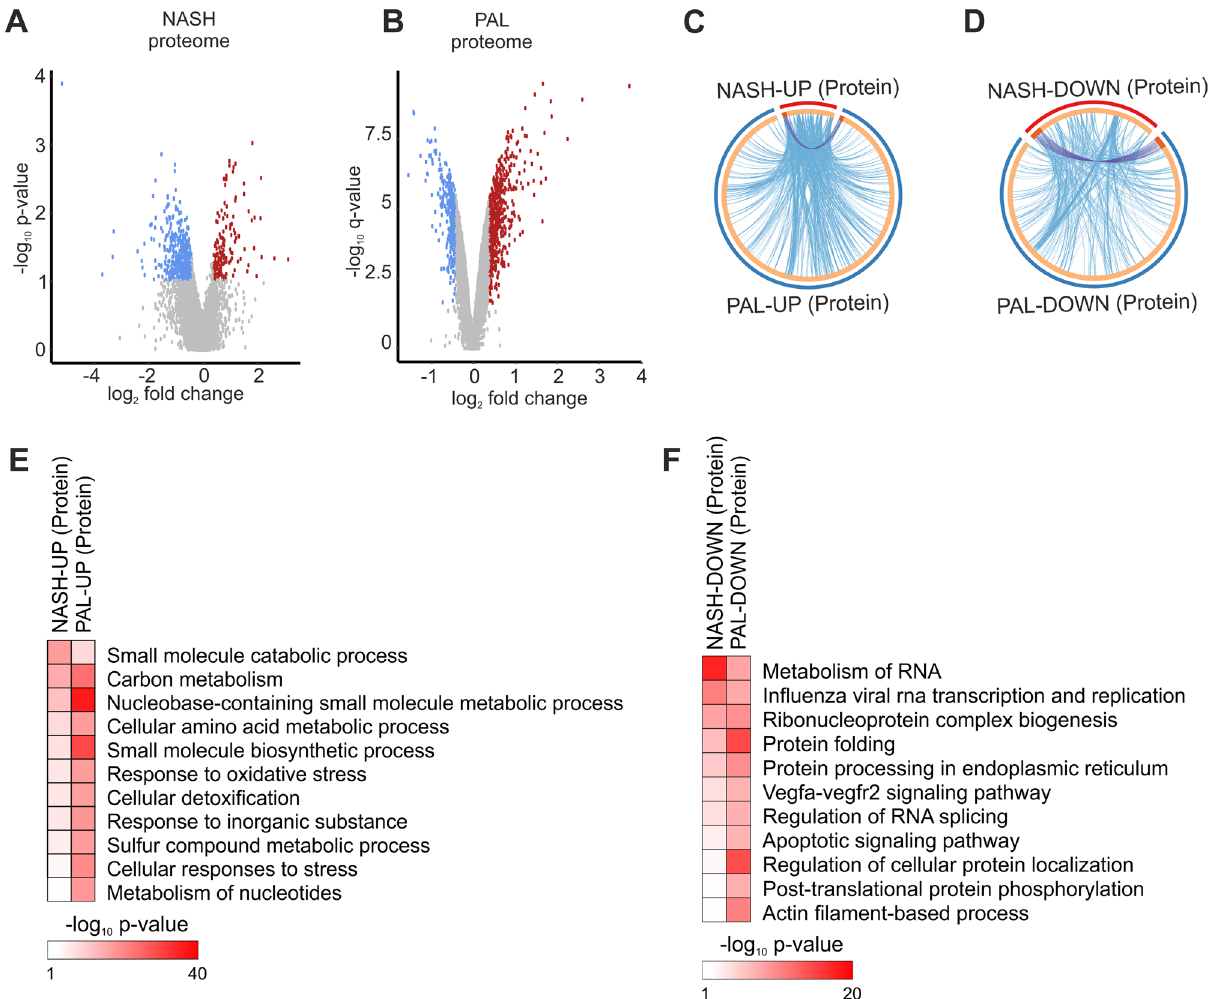
Figure 2. Shared proteome remodelling in NASH and lipotoxicity. ( A , B ) Volcano plots showing differentially regulated proteins in ( A ) human liver from NASH patients (n = 4 per group) and ( B ) mouse hepatocytes stimulated with PAL for 24 h (n = 3 per group). Blue and red dots denote significantly down- and up-regulated proteins, respectively. ( C , D ) Circular plots showing the protein (purple lines) and functional (blue lines) overlap between ( C ) up- and ( D ) down-regulated proteins in human NASH and mouse hepatocyte lipotoxicity. ( E , F ) Gene ontology analysis showing biological processes significantly regulated in both human NASH and mouse hepatocyte lipotoxicity ( E ) up- and ( F ) down-regulated